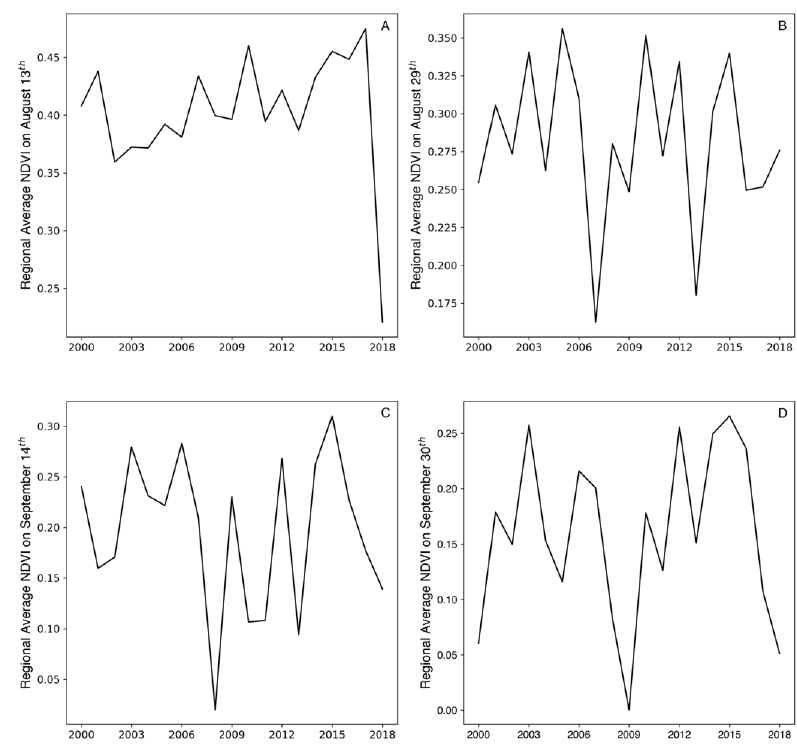
Figure 15. Regional-averaged 16-day MODIS NDVI on selected dates in the fall.